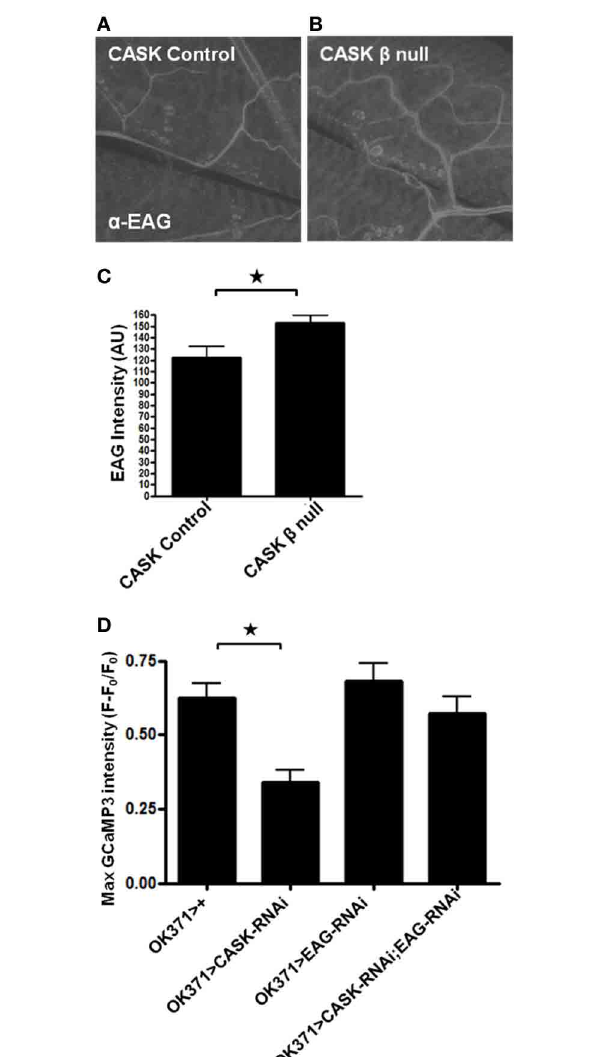
FIGURE 5 | Signaling downstream of CASK in calcium signaling and synaptic growth. (A,B) Representative images of EAG staining at the NMJ in control and CASK β null larvae. (C) CASK β deletion significantly increased the intensity of EAG staining at the NMJ ( p < 0 . 05, n = 6, unpaired t -test). (D) GCaMP3 imaging of the ventral ganglion during fictive crawling shows that the decrease in peak Ca 2 + level induced by CASK knockdown was rescued by EAG knockdown. EAG knockdown alone did not significantly increase Ca 2 + signaling ( p > 0 . 05, n = 5–6, One-Way ANOVA with a Bonferroni post-hoc